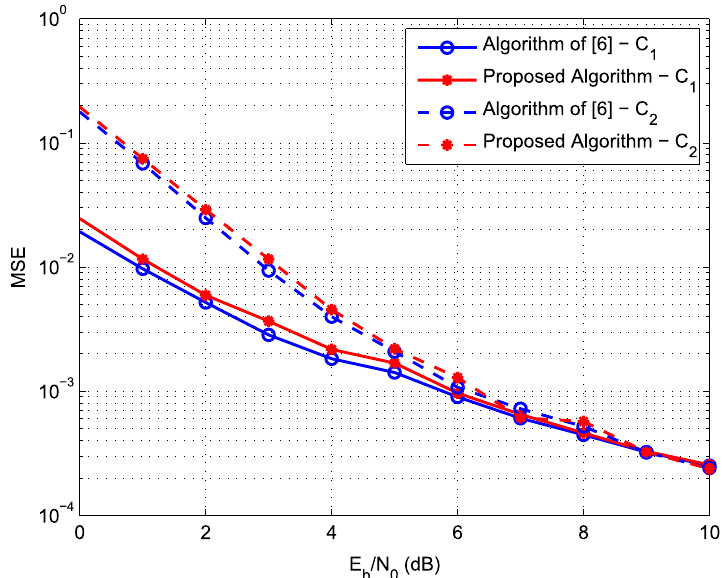
Fig. 5 MSE curves of the proposed algorithm applied to two LDPC codes of length n = 648 bits and rate R = 1 / 2 . Code C 1 : u i = 4 , Code C 2 : u i =